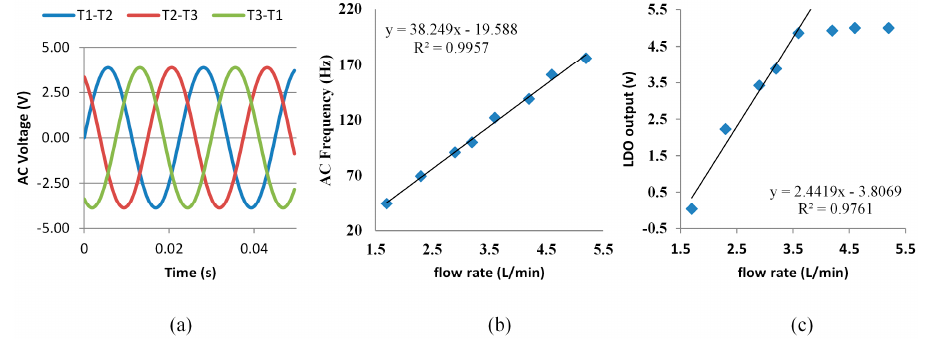
Figure 7. ( a ) The output signals of three loops of the stator at a flow rate of 1.7 L/min; ( b ) Frequency of the sinusoidal waveform of the one of three loops of the stator as a function of the water flow rate; ( c ) The output voltage of the LDO regulator as a function of the water flow rate.